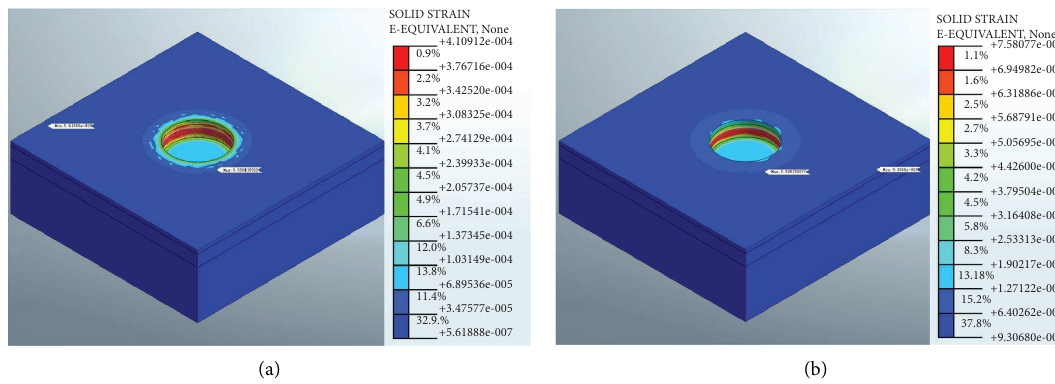
Figure 17: Working condition 8. Equivalent soil strain (a) without pore water pressure and (b) with pore water pressure applied.